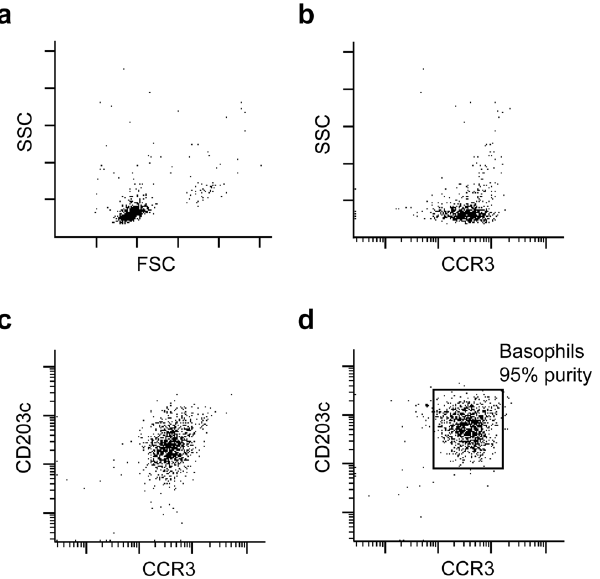
Fig 1. Determination of basophil purity. ( a ), Forward/side scatter plot of purified basophil fraction. ( b ), CCR3 expression of the recorded events. ( c ), a representative non-stimulated cell sample showing a putative basophil population. ( d ), upon stimulation with anti-Fc ε RI the CCR3 positive/CD203c shifting population was gated for purity determination. In this representative sample basophil purity was 95%.